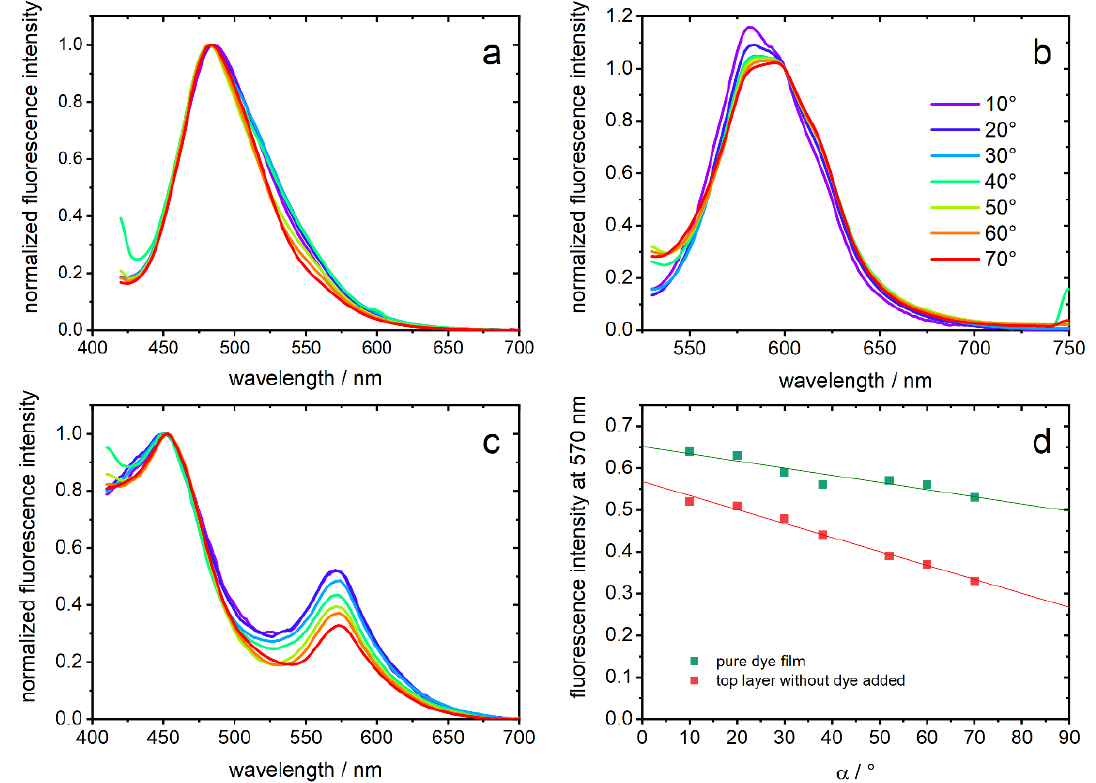
Figure 6. Emission spectra of polymer films with embedded dye: ( a ) PGMMA- ( λ exc = 400 nm), ( b ) HEMA- ( λ exc = 500 nm), and ( c ) PIPGMA-containing opal film ( λ exc = 380 nm) at indicated angles α between film surface and detection pathway. ( d ) The fluorescence intensity at 570 nm from ( c ) is plotted against α for a PIPGMA-containing opal film with and without a top layer of PIPGMA without dye.